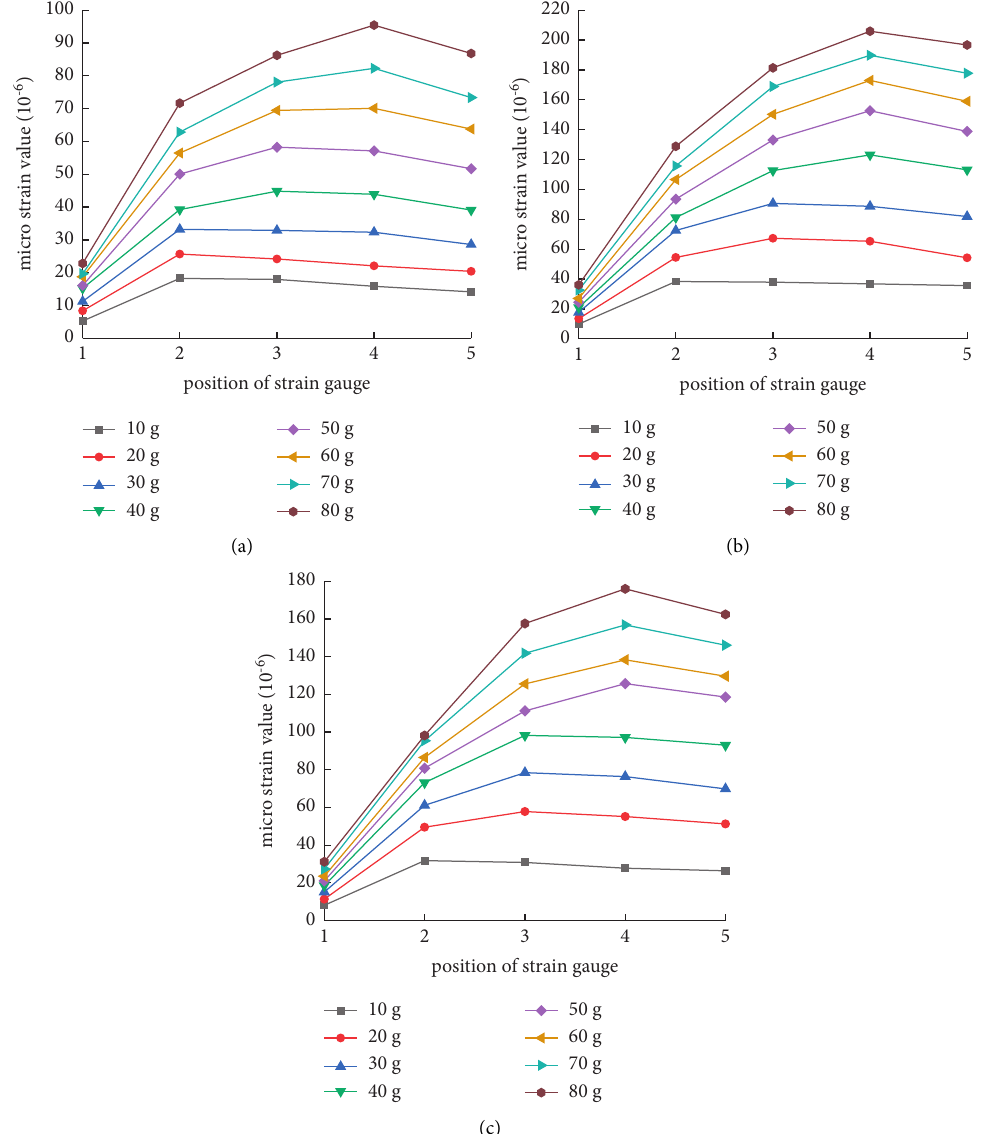
Figure 13: Axial strain distribution of test anchor rod. (a) 1# anchor rod. (b) 2# anchor rod. (c) 3# anchor